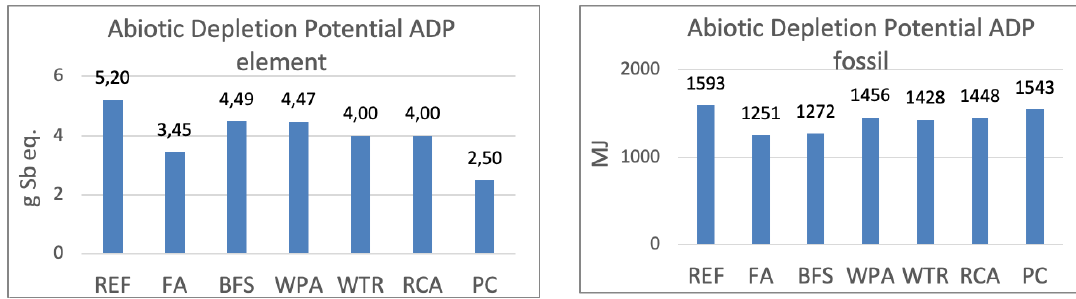
Figure 1. Comparison of 1 m 3 of concrete mixtures regarding sustainability.